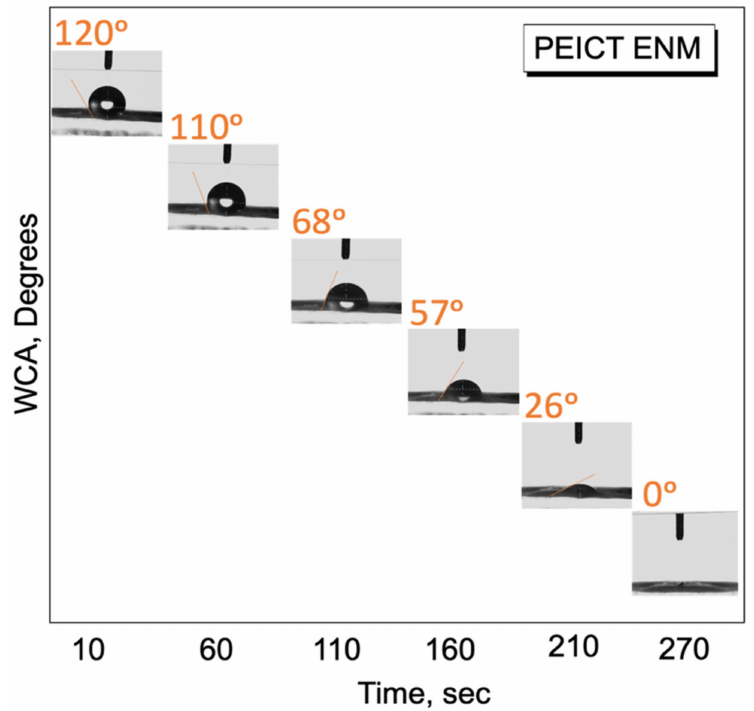
Figure 5. Water contact angle test of PEICT